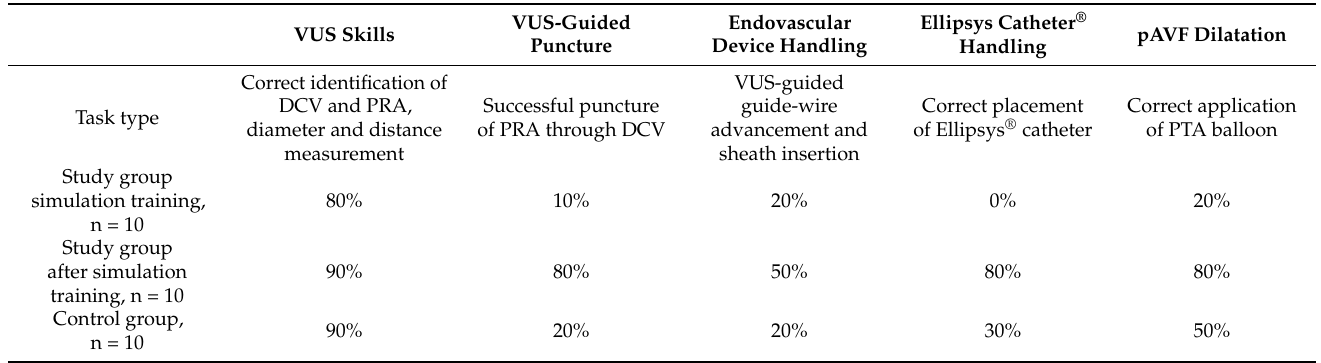
Table 1. Independent pAVF task accomplishment.